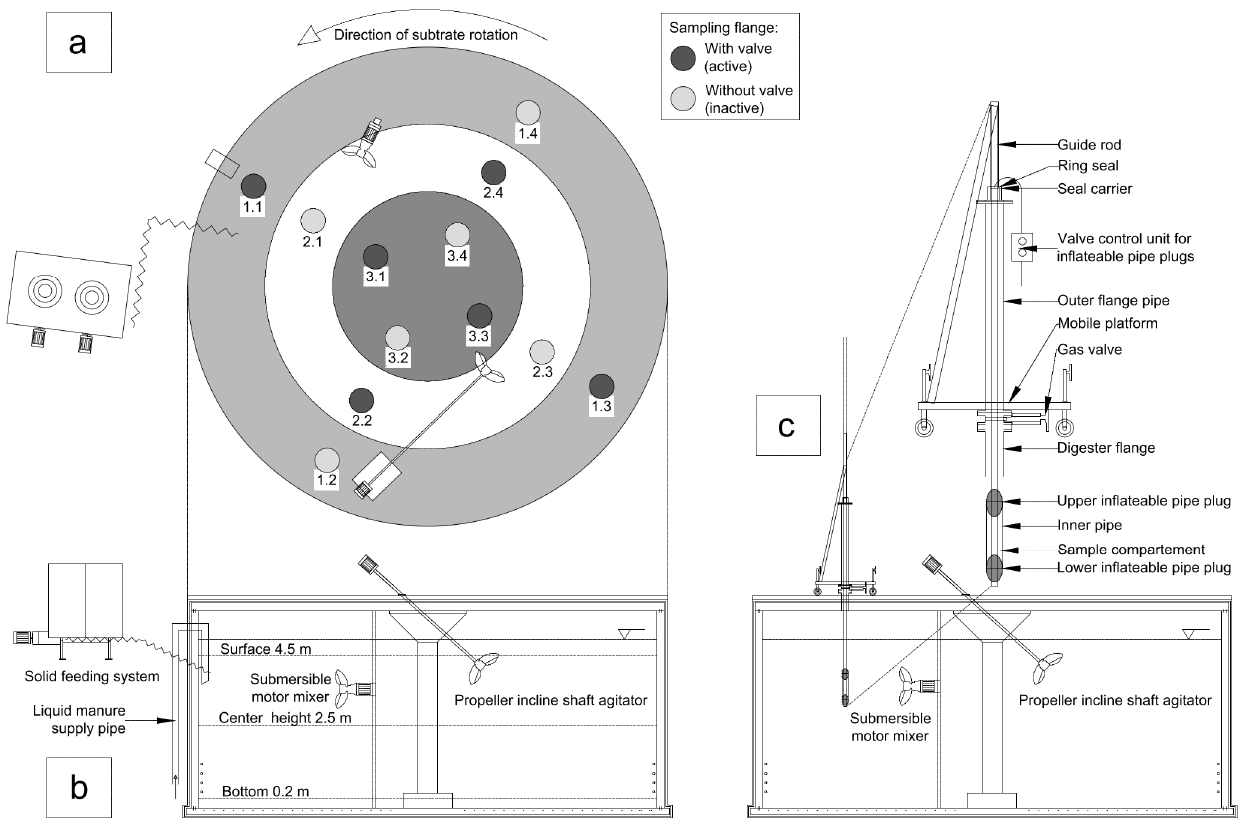
Figure 3. Plan view on digester one with probe: ( a ) sampling points and ( b ) sampling heights; ( c ) Represents the probe sampling system on the digester, enlarged and provided with additional technical